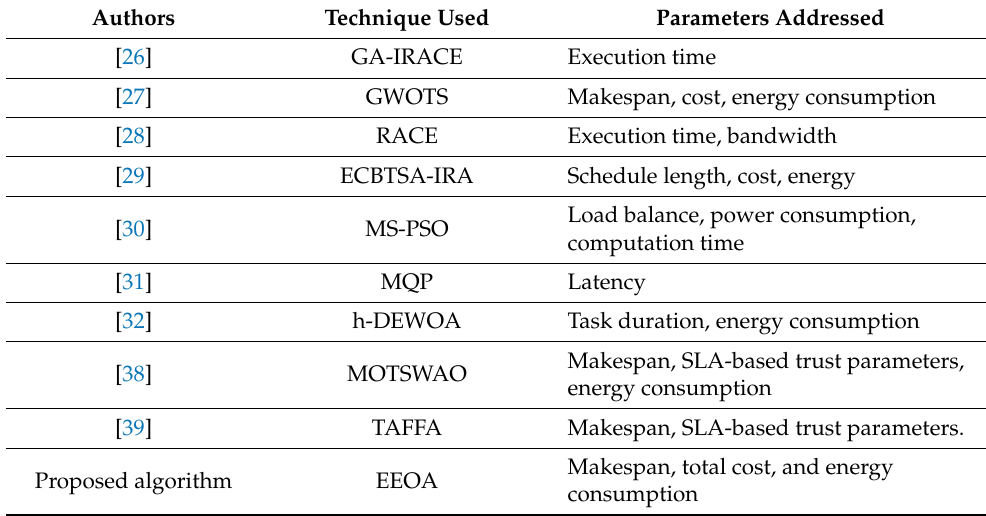
Table 1. Analysis of scheduling parameters in the related